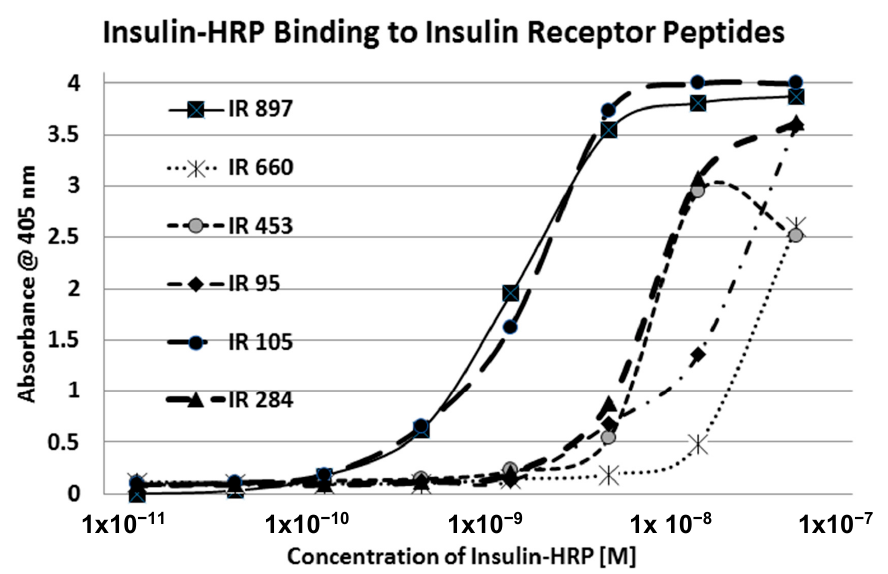
Figure 7. Binding curves for insulin – HRP binding to some of the insulin receptor (IR) peptides utilized in these experiments. Sequence numbers of the IR refer to the Table I, which contains additional data. See also [41,42].